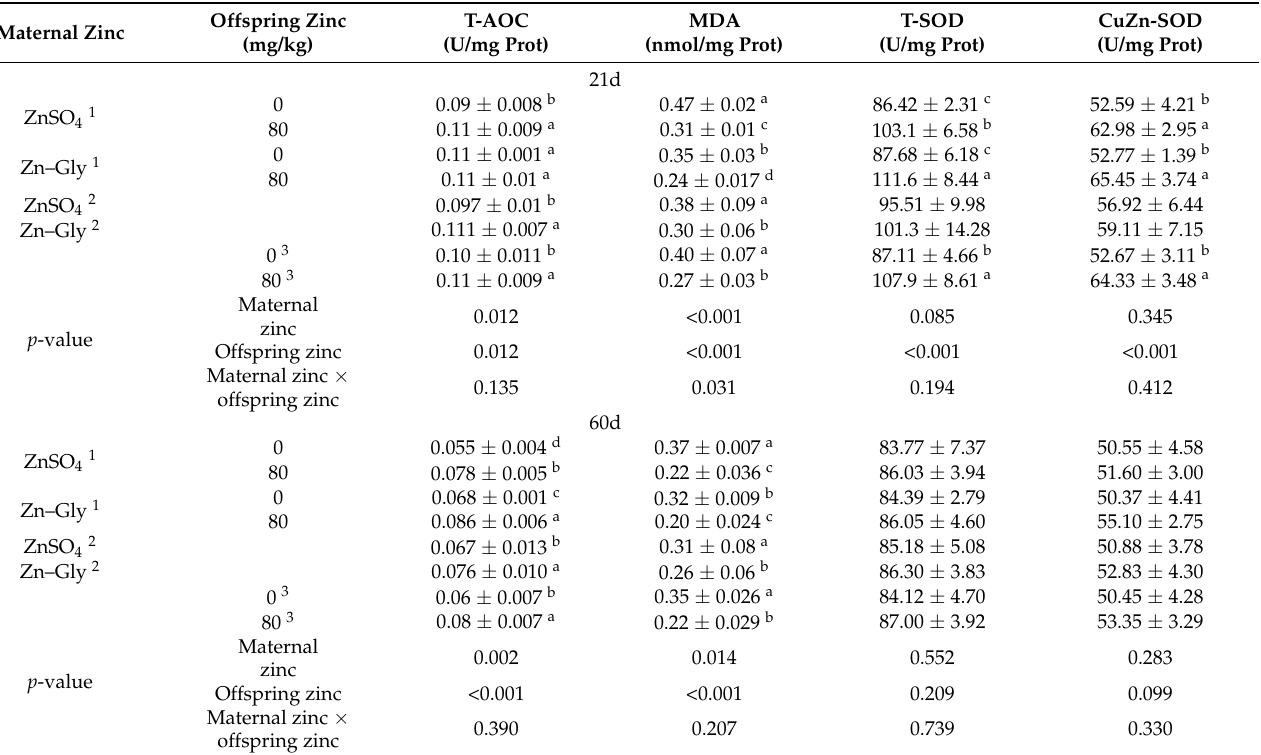
Table 7. Effects of maternal Zn in conjunction with their offspring dietary Zn supplementation on muscle antioxidant indexes in offspring broilers (mean ±